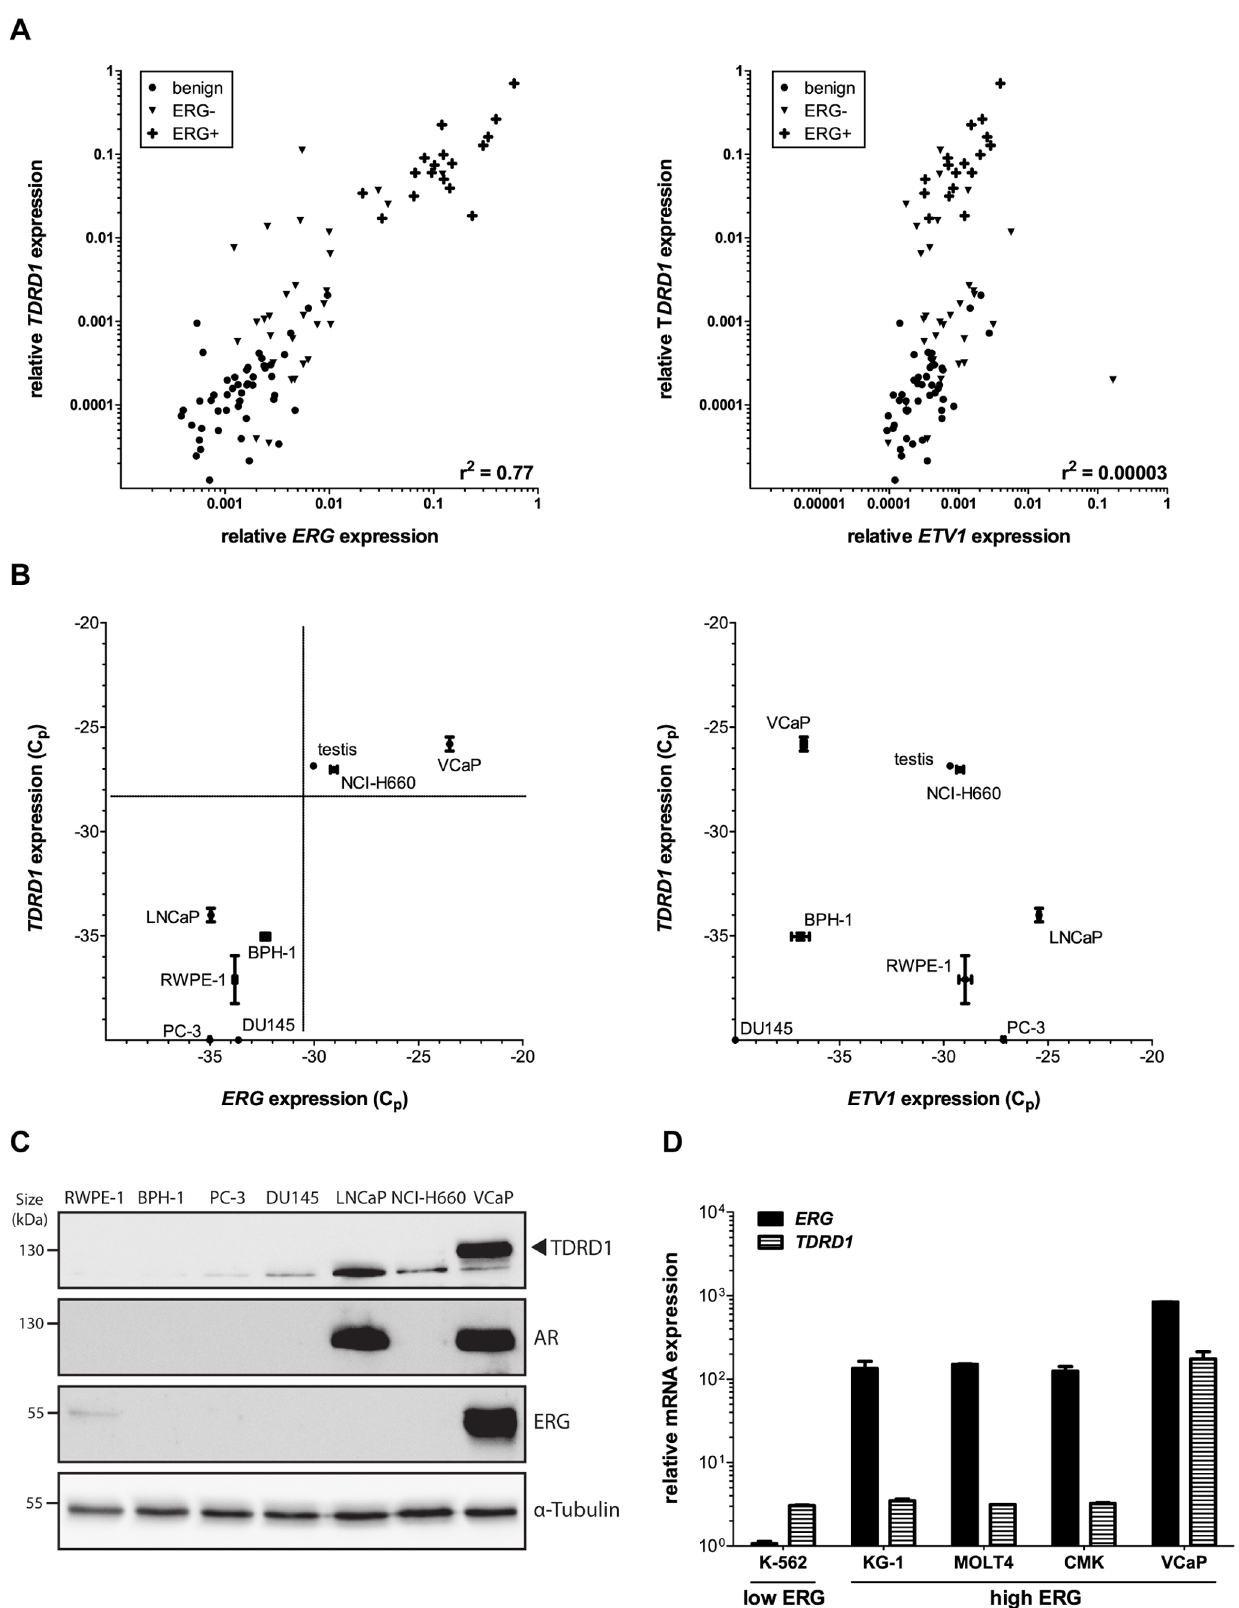
Figure 1. TDRD1 is co-expressed with ERG but not with ETV1 in prostate cancer. (A) Correlation analysis of mRNA levels measured by qRT- PCR in TMPRSS2:ERG -negative (ERG-, n=30) and TMPRSS2:ERG -positive (ERG + , n=17) prostate cancers as well as adjacent benign prostate tissue (n=46). Pearson correlation coefficient is shown. (B) Analysis of mRNA expression in prostate cell lines by qRT-PCR. Two independent experiments PLOS ONE |